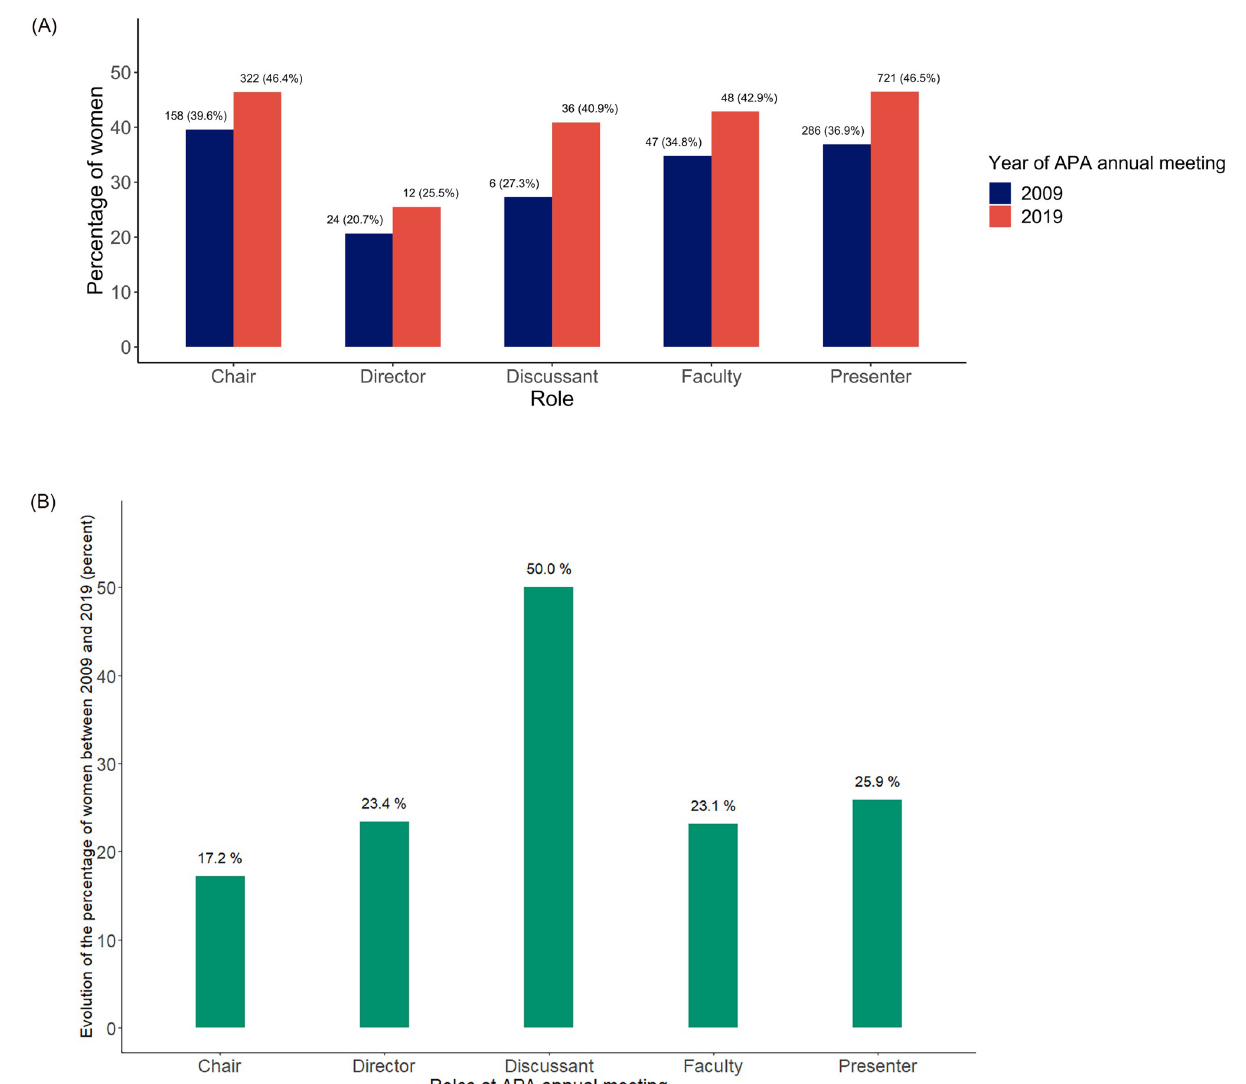
Fig 1. A. Rate of women per role, 2009 versus 2019. B. Change in rate of women per role.